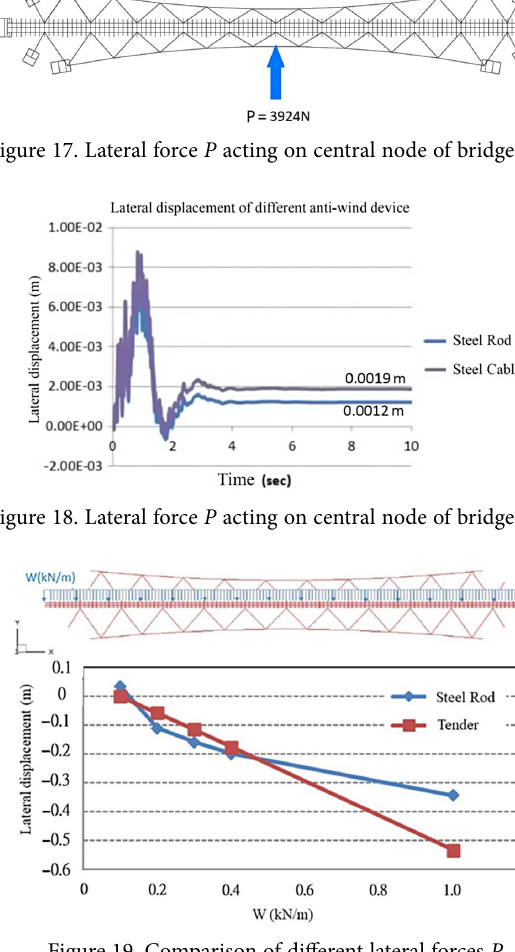
Figure 19. Comparison of different lateral forces P and transverse displacement with two